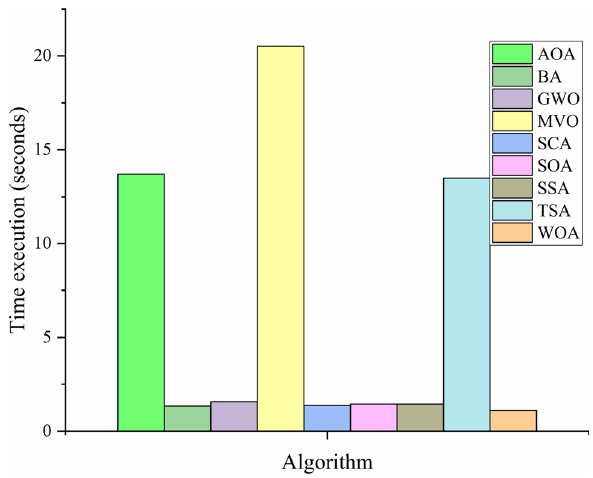
Fig. 21 The time execution of the algorithms for case 3